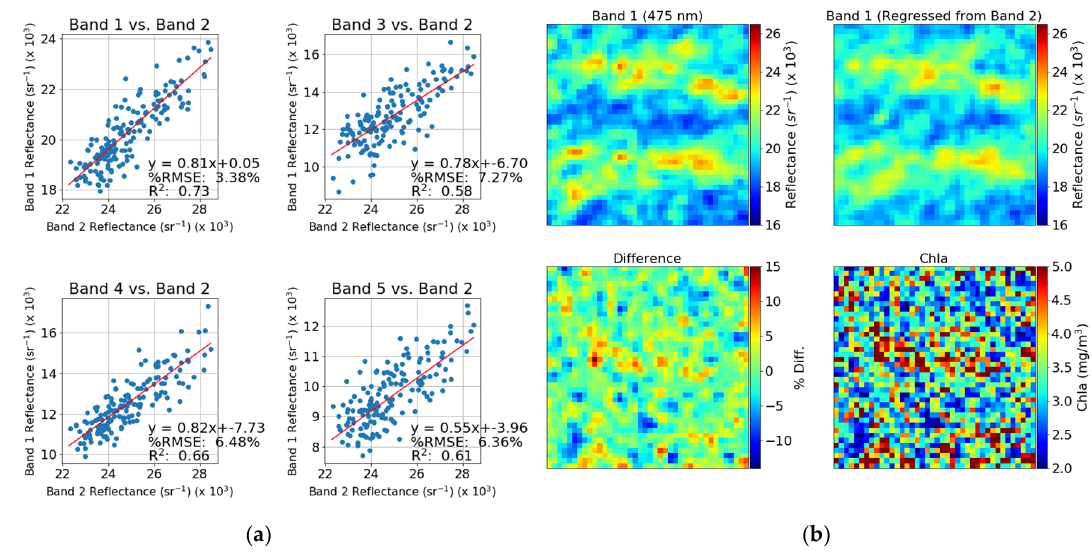
Figure 7. ( a ) Regression results between the water reflectance for multispectral bands, with respect to Band 2, and ( b ) water reflectance for a 40 × 40 pixel subset area of Band 1, Band 1 estimates regressed from Band 2, the difference, and Chla estimates from the two bands.